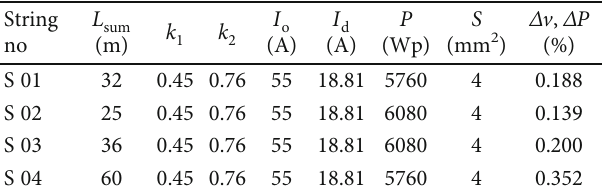
Figure 3: Project block diagram of the general arrangement. Table 1: Calculations for the DC voltage drop ( E ), power dissipation, and